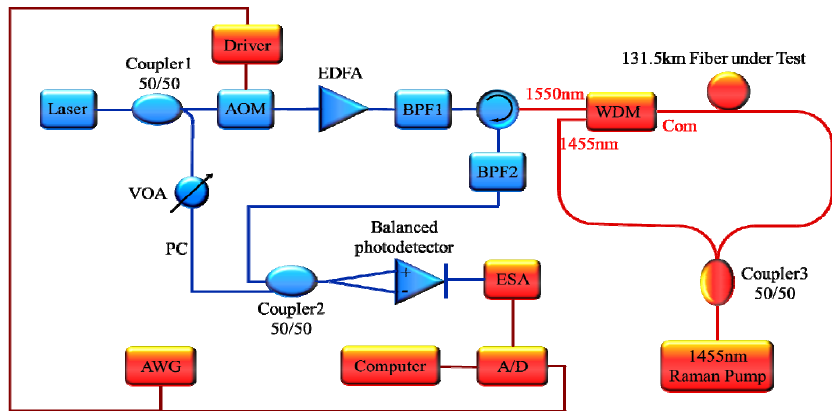
Fig. 3 Ф -OTDR system based on bi-directional 1 st -order DRA and heterodyne detection.